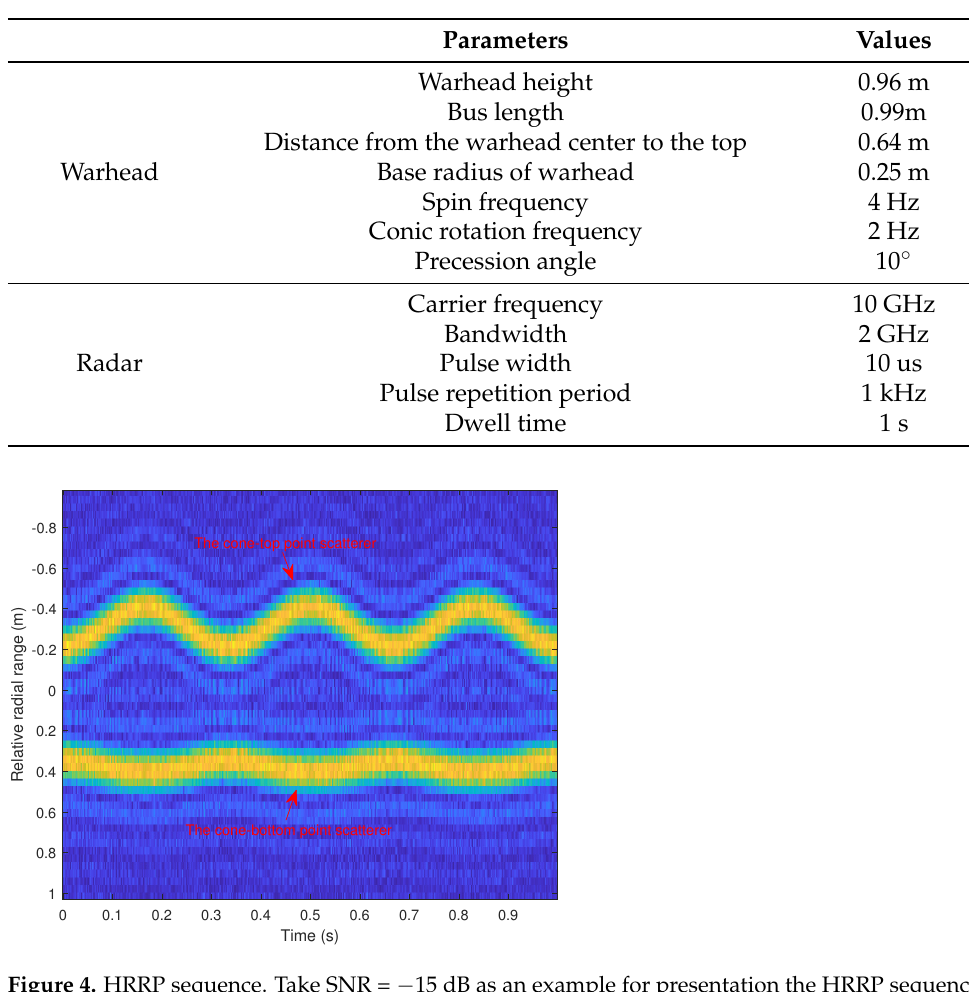
Table 2. Simulation parameters.